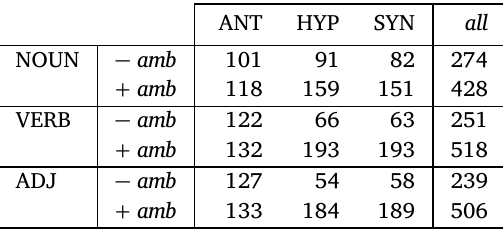
Number of relation pairs in the